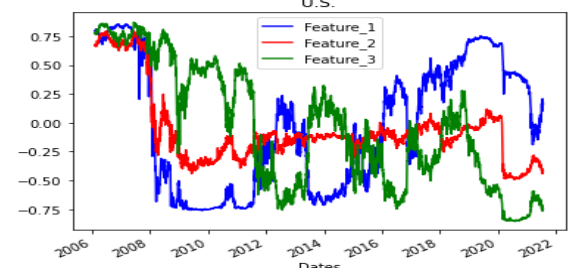
Figure 12. US AE prediction result.